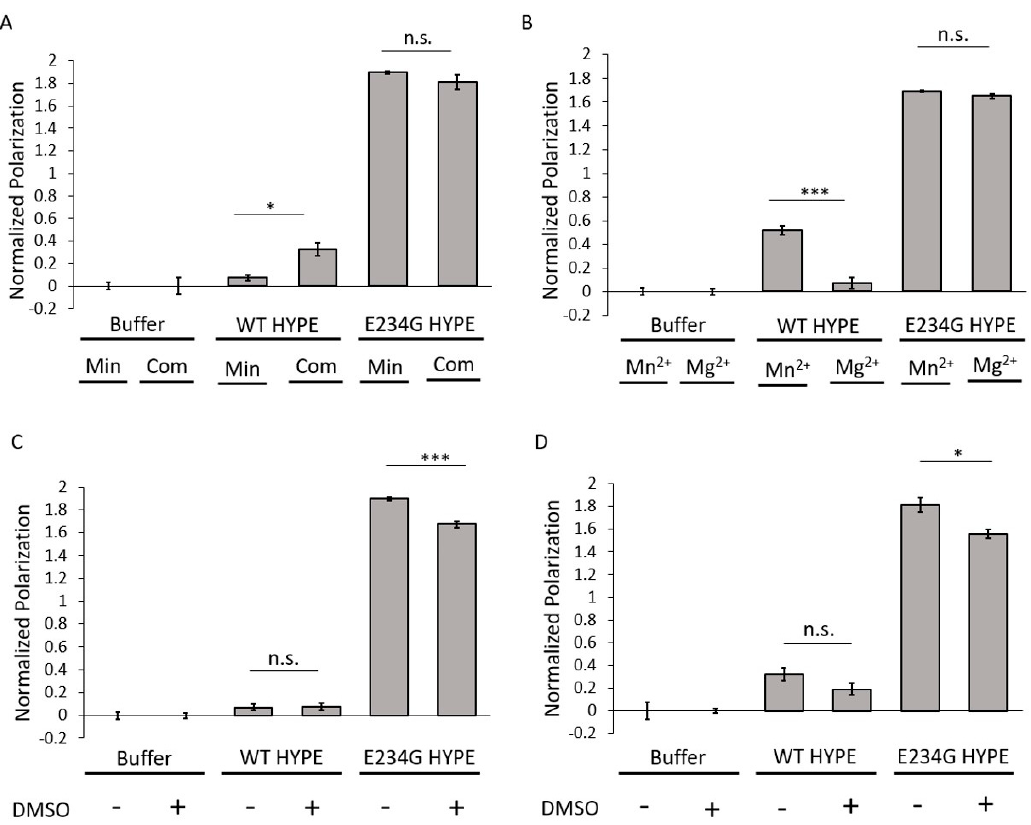
Figure 2. AMPylation buffer assessment. ( A ) Comparison of Δ 102 WT and E234G HYPE autoAMPylation in complete (Com) or minimal (Min) buffer (see Methods). ( B ) Comparison of Δ 102 WT and E234G HYPE autoAMPylation with buffer containing Mn 2+ or Mg 2+ . ( C ) Comparison of Δ 102 WT or E234G HYPE autoAMPylation with or without 1% DMSO in a minimal buffer background. ( D ) Comparison of Δ 102 WT or E234G HYPE autoAMPylation with or without 1% DMSO in a complete buffer background. All samples were normalized to buffer controls. Data represented as the mean +/– SEM of four replicates. Unpaired t -tests were performed: * = p < 0.05; *** = p < 0.001.